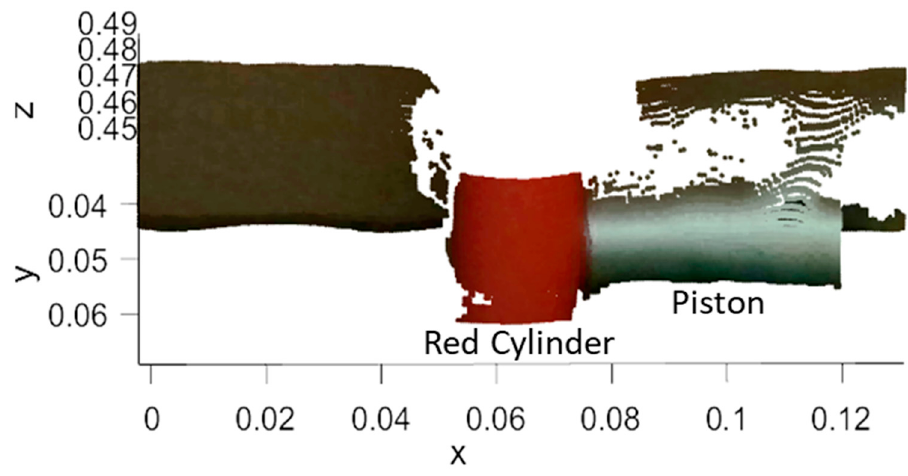
Figure 5. Point cloud representing the elements of a frame in a typical acquired scene.